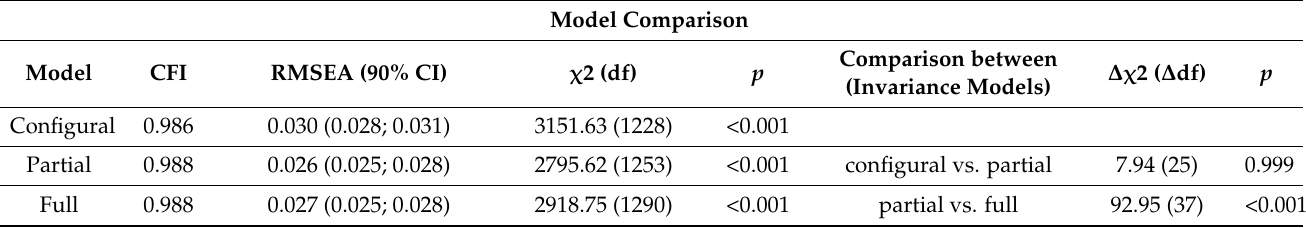
Table 6. Results of Measurement Invariance testing: Model comparison.